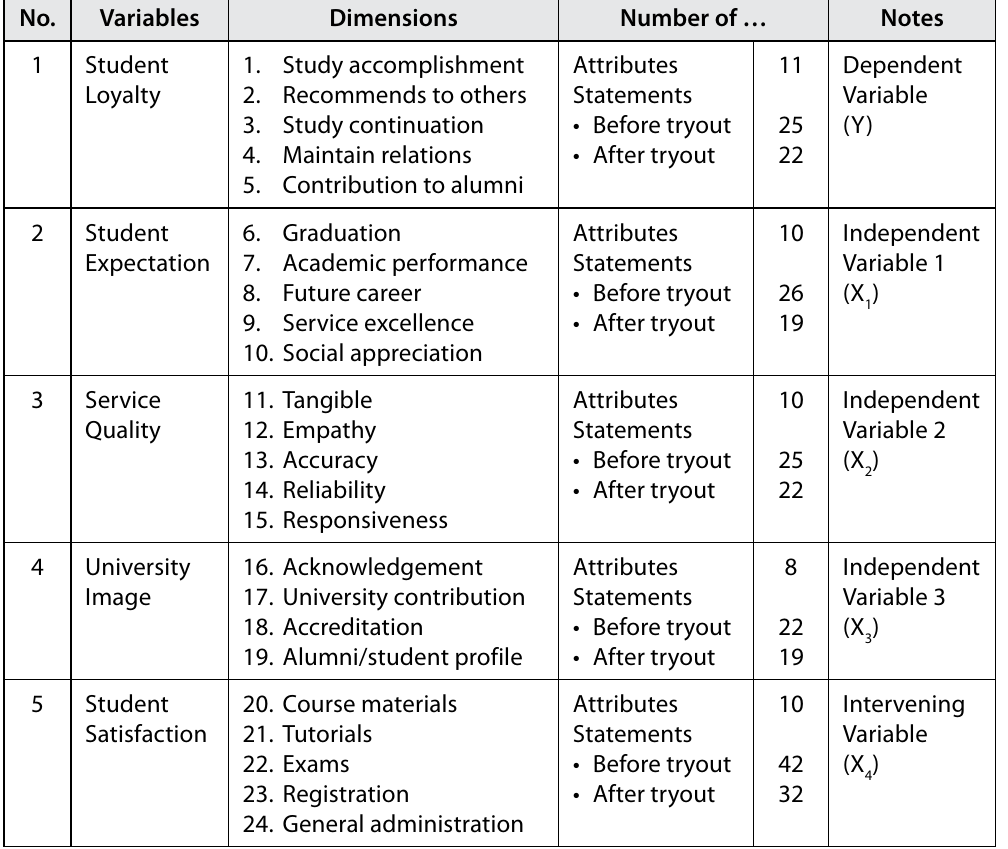
Table 2 Variables, dimensions, attributes and statements